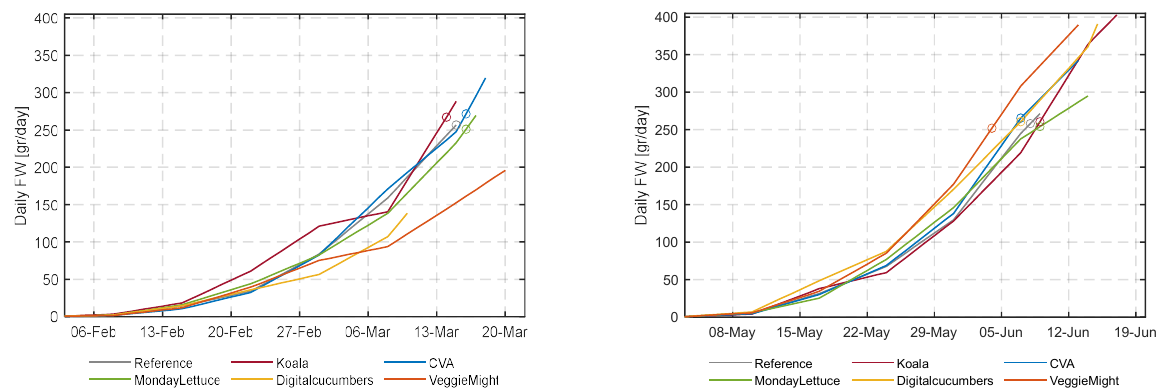
Figure 12. Development of fresh weight [g/plant] in the different compartments for the first and second cultivation. The curves were obtained by linear interpolation of the weekly randomly sampled plants and (destructively) weighed heads of lettuce. The end of the lines represents the chosen date of harvest and the fresh weight at harvest. The circles (o), represent the days on which the lettuce heads reached the target fresh weight of 250 g.